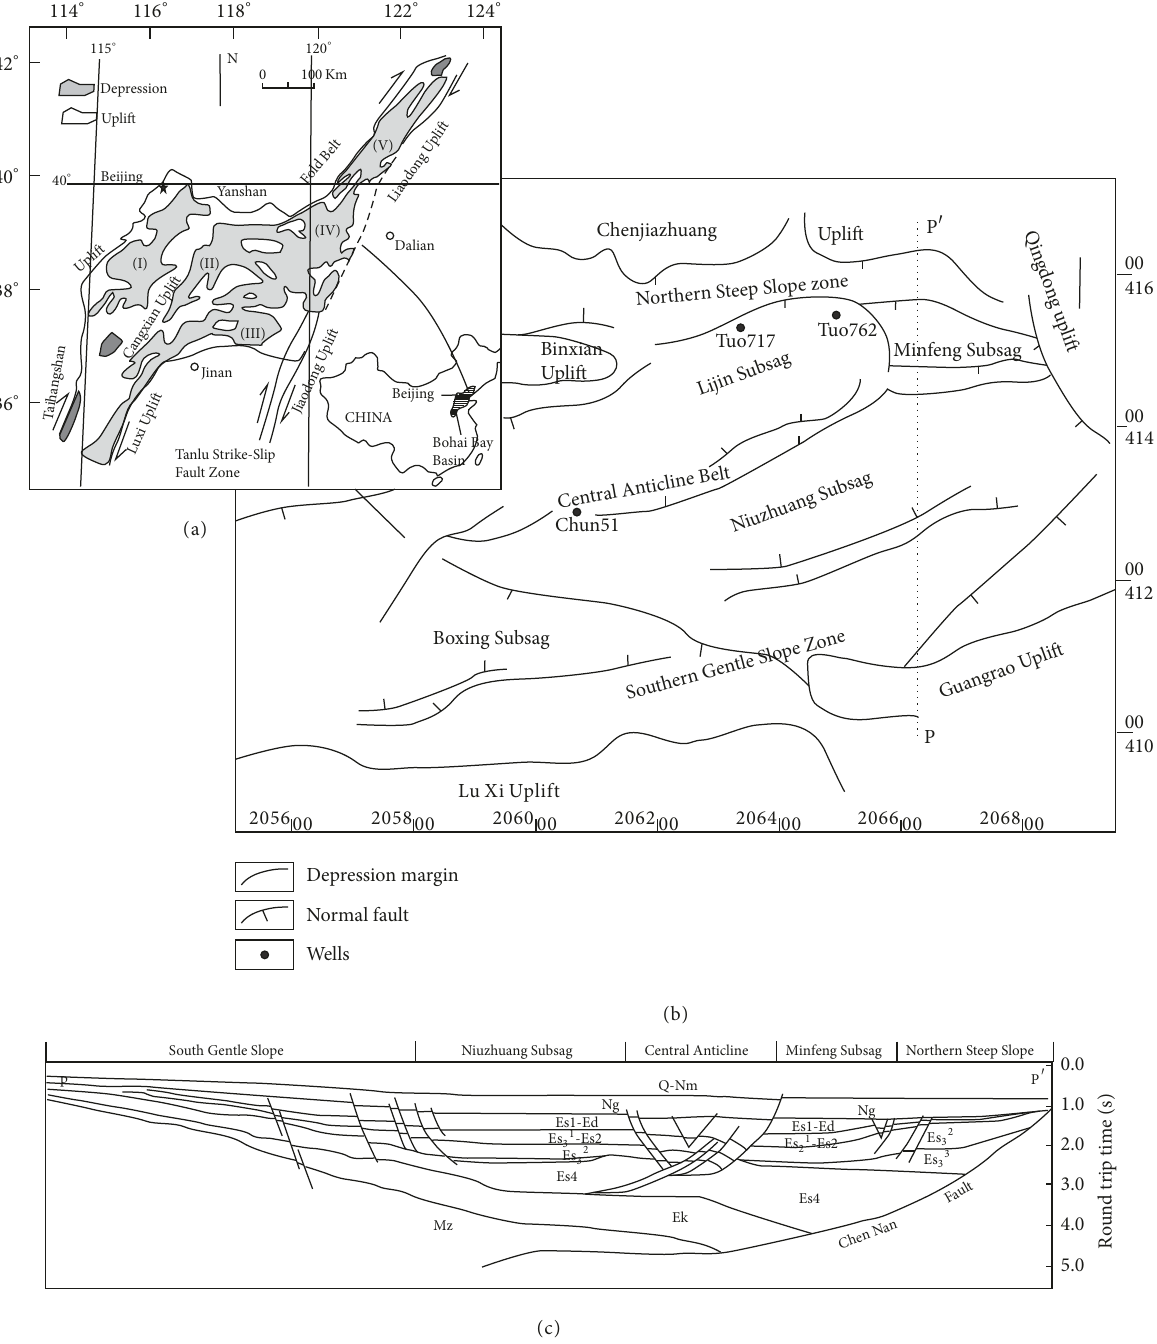
Figure 1: Location map and cross section of the study area . (a) Location map of the study area showing the subtectonic units of the Bohai Bay Basin, namely, Jizhong Depression (I), Huanghua Depression (II), Jiyang Depression (III), Bozhong Depression (IV), and Liaohe Depression (V). (b) Structural map of the Dongying Sag. (c) N–S cross section (P 󸀠 –P) of the Dongying Sag showing the various tectonic-structural zones and key stratigraphic intervals